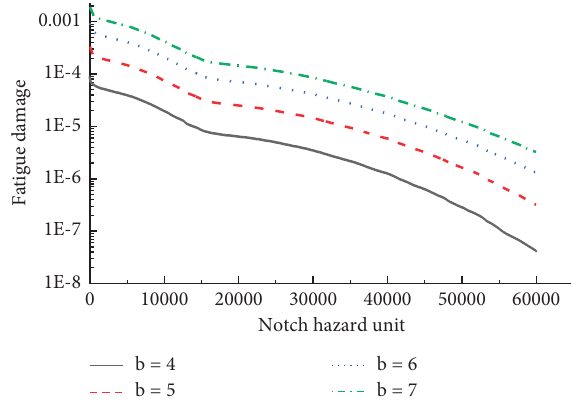
Figure 14: Damage comparison by the harmonic response method (change in acceleration parameter